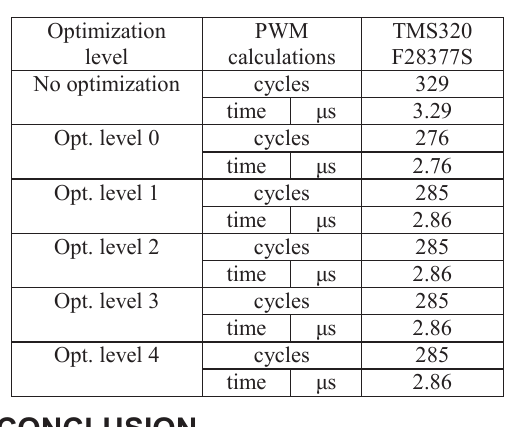
Table 1. The execution time and cycles of PWM